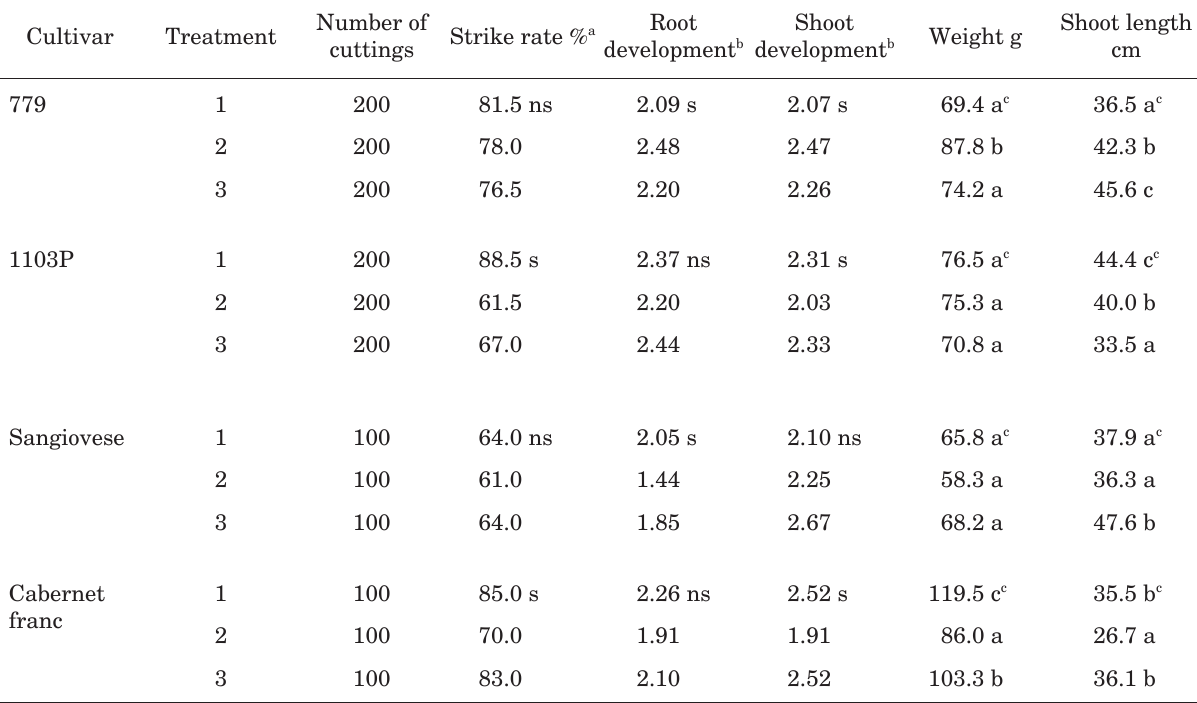
Table 6. Growth parameters of vines obtained from 779P, 1103P, Sangiovese and Cabernet franc cuttings treated with hot water before (1) or after (2) cold storage, or untreated (3) in 2007.